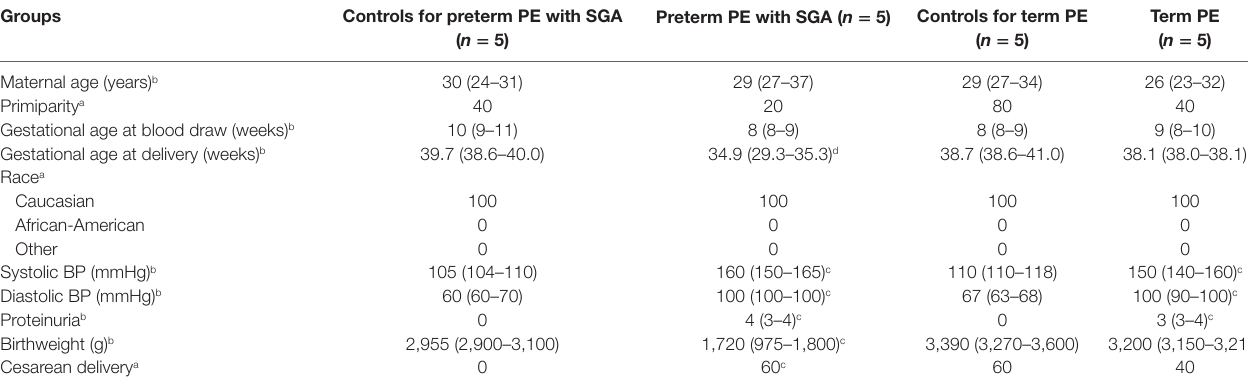
Term Pe ( n = 5) ( n = 5)